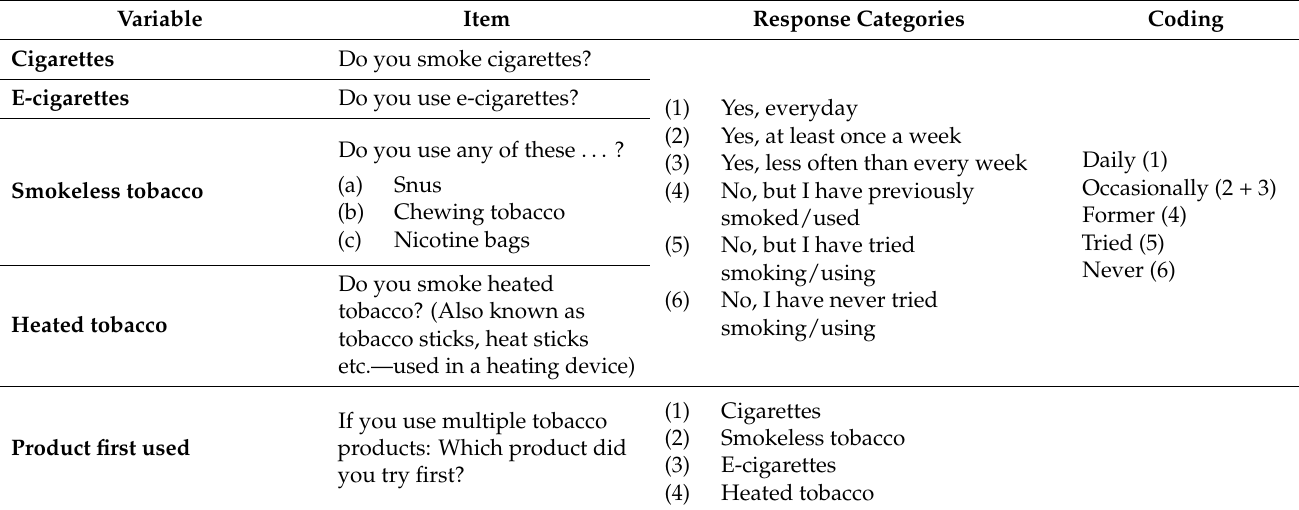
Table 2. Measures of current tobacco or nicotine product use, and first product